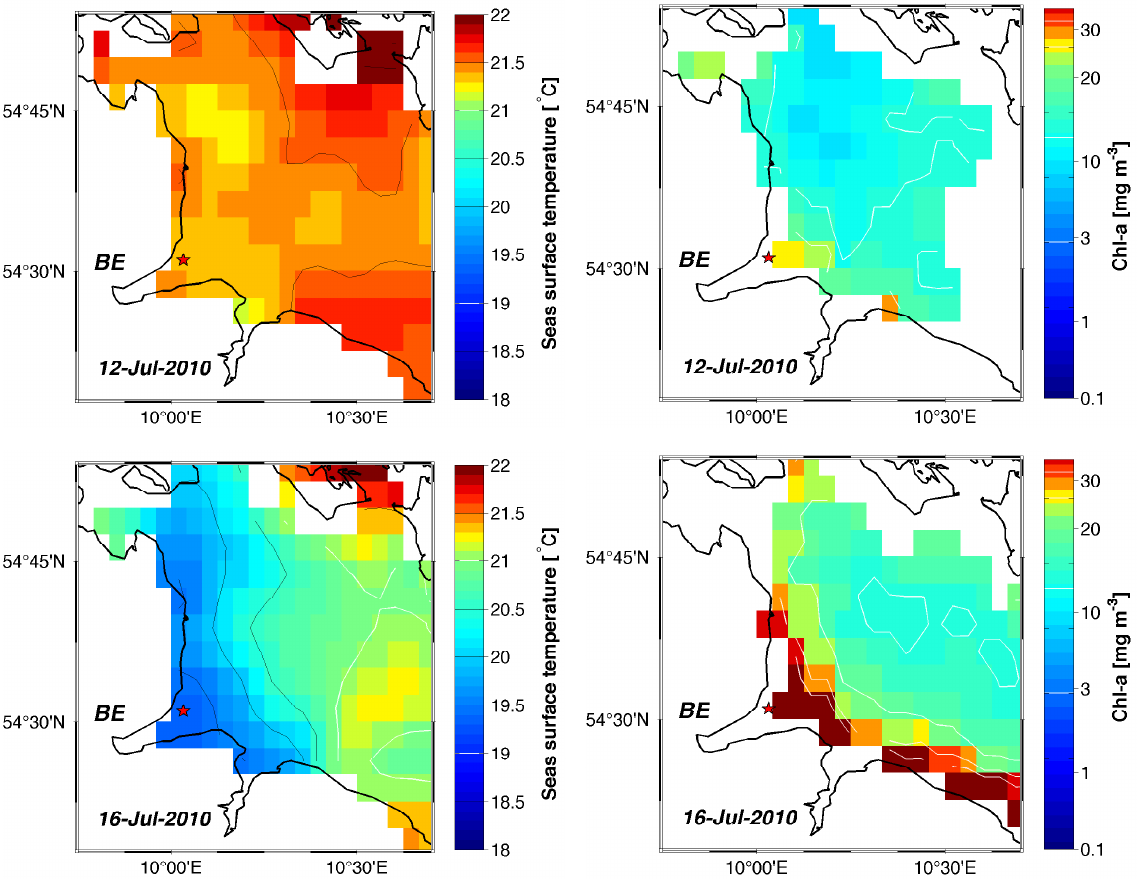
Figure 3. Sea surface temperature (left) and chlorophyll a (right) distribution from MODIS Terra satellite before the two upwelling events (upper) and after the second upwelling (lower). Boknis Eck time-series site is indicated (red star) and labelled (BE).